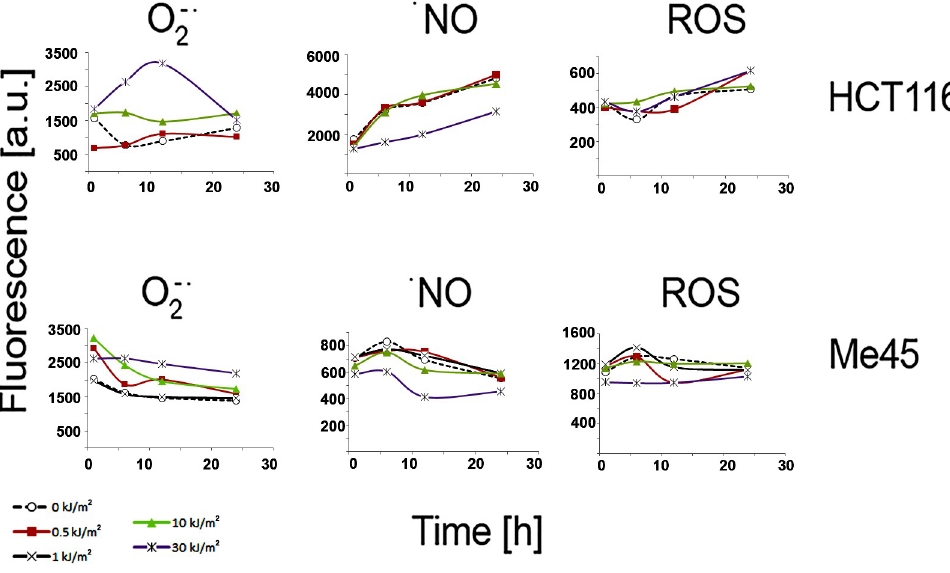
Fig 3. The dynamics of the levels of superoxide, nitric oxide and ROS detected by DCFH-DA in control and UVA irradiated cells. Each curve represents the results after exposure to a particular UV dose shown on the right; data are means from three experiments and error bars are not shown for